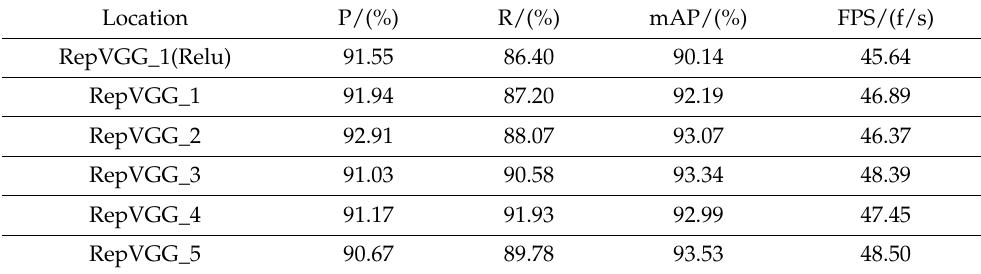
Table 1. Experimental results of RepVGG at different locations. P stands for precision rate, R stands for recall rate, FPS stands for frame per second, and mAP stands for mean average preci- sion.